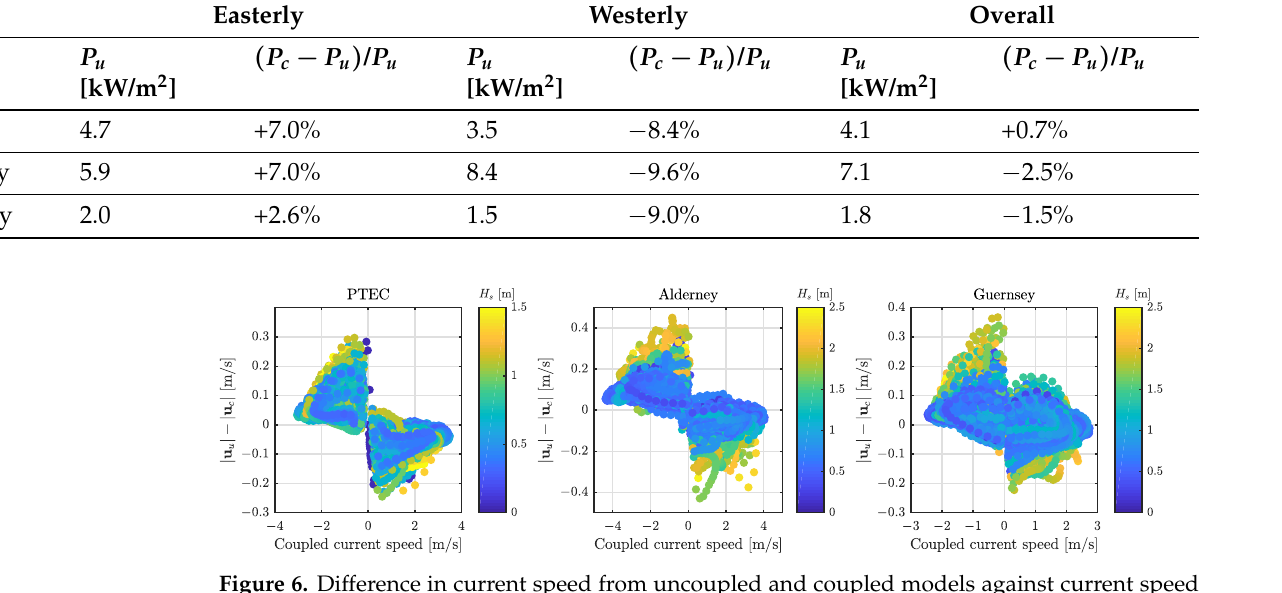
Figure 6. Difference in current speed from uncoupled and coupled models against current speed from the coupled model (positive when easterly component is positive). The color of points indicates concurrent significant wave